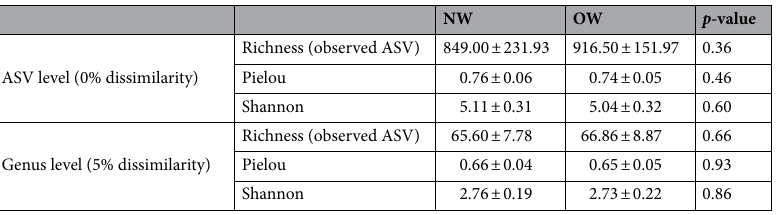
Table 5. Diversity indices (mean ± standard deviation) in the faecal microbiome of recruited lean (NW, n = 15) and overweight (OW, n = 14)